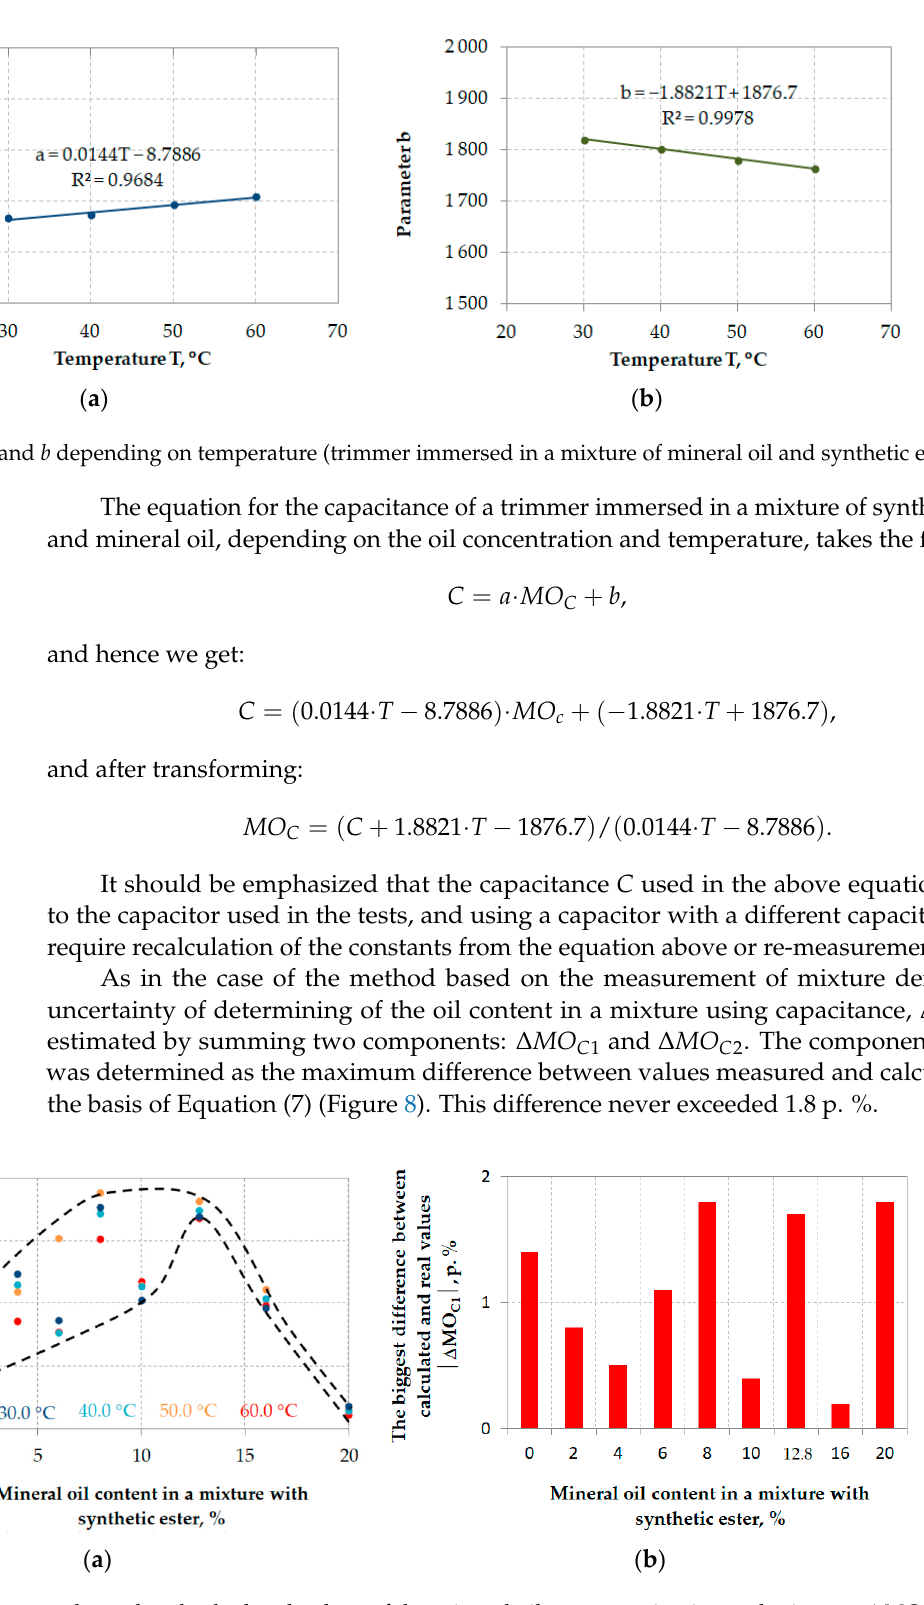
8 of 12 Figure 6. Capacitance C of a trimmer immersed in mineral oil and synthetic ester mixtures as a function of oil concentration for different temperatures. Table 4. Values of parameters a and b depending on temperature calculated based on data pre- sented in Figure 6. Temperature, °C